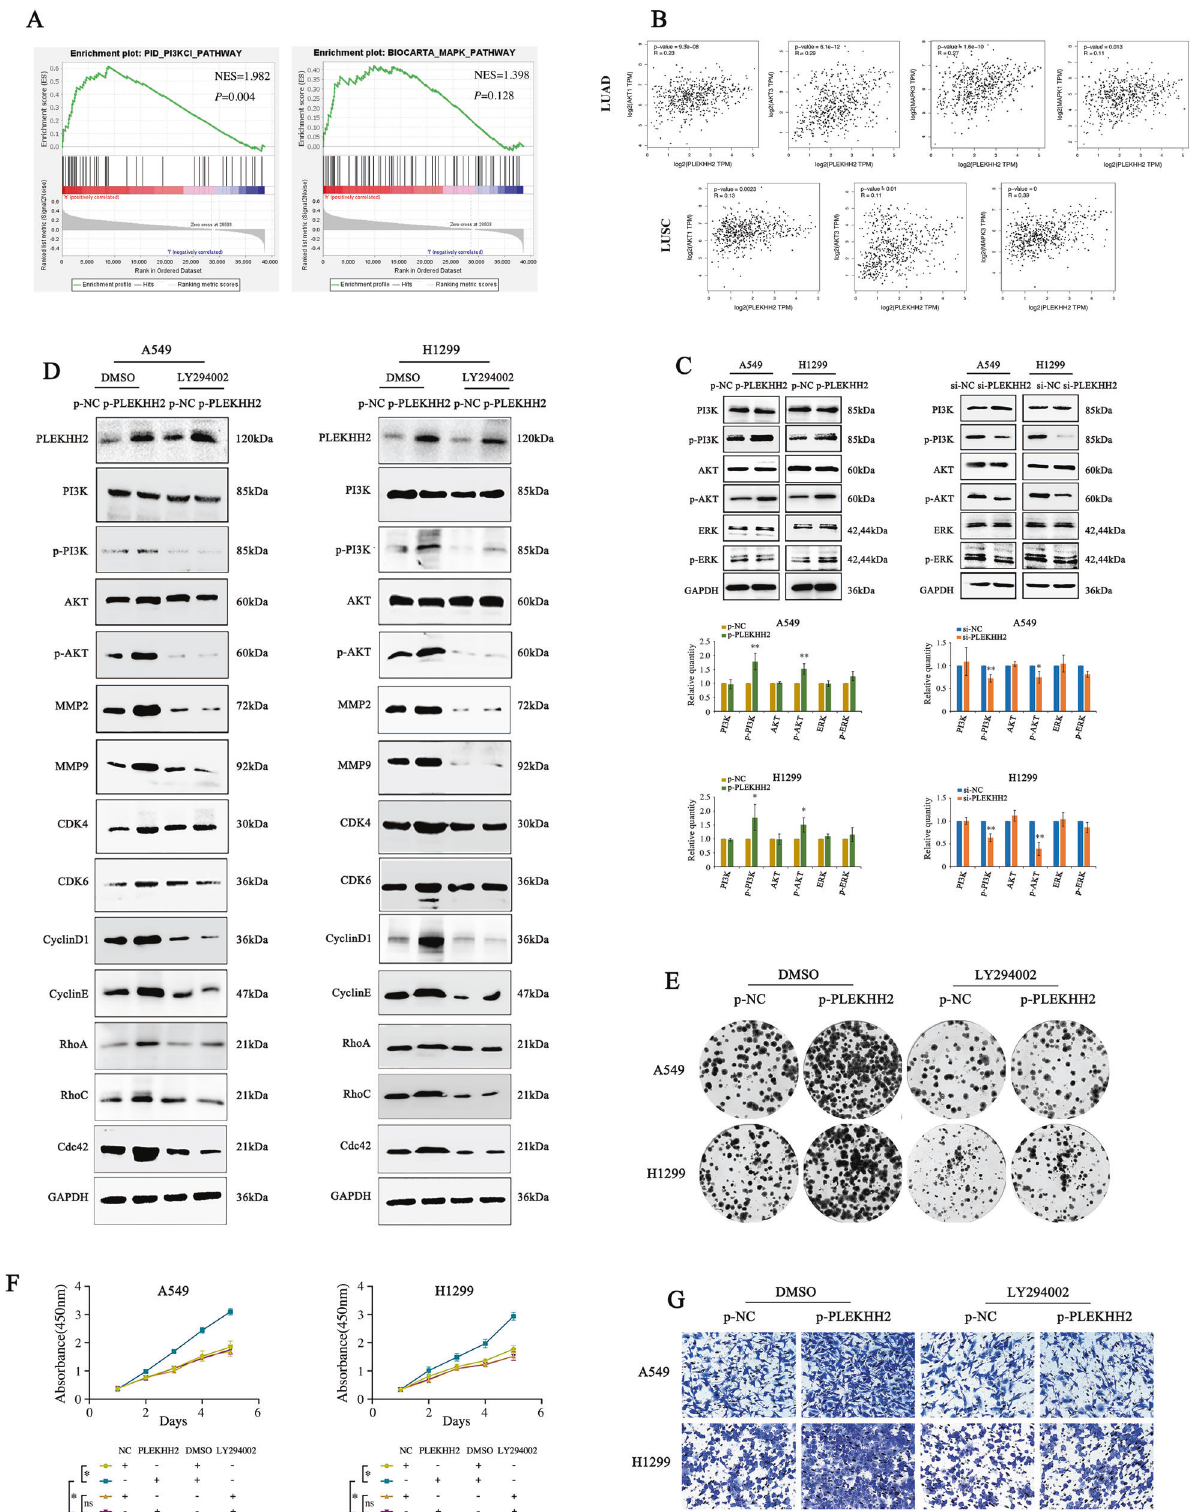
complex and incompletely understood, abnormal activation of PI3K/AKT is the explicit mechanism leading to EGFR-TKI resistance in lung cancer cells [34 – 36]. Increased PLEKHH2 binding to β -arrestin1 through its FERM domain activates FAK/PI3K/AKT phosphorylation. Therefore, PLEKHH2, acting as a regulator of